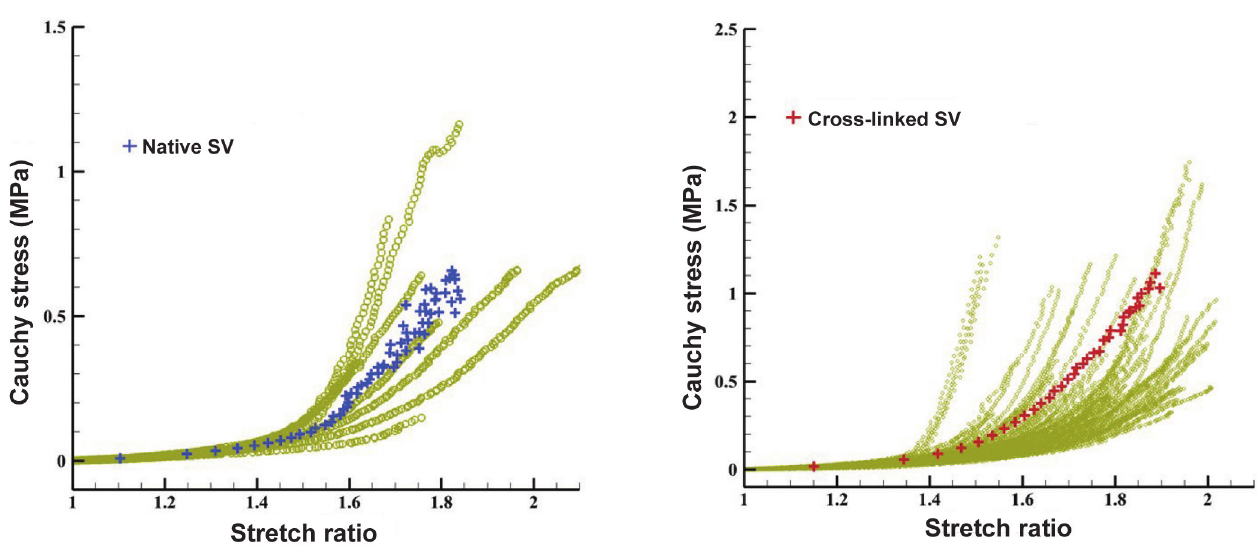
Fig. 2 - Stain-stretch relationships of the native and cross-linked saphenous veins (SVs). In the high-stretch region (stretch ratio: 1.4-1.8), the circumferential stress in the cross-linked SV was higher than that in the native SV indicating decreased extensibility and reinforced venous wall of the